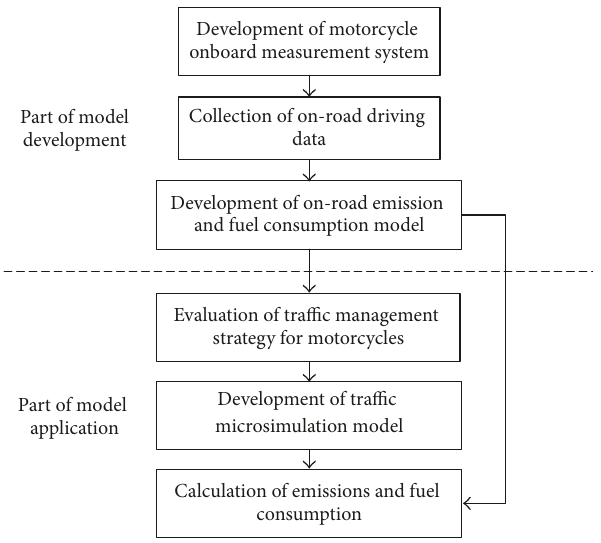
Figure 1: Research